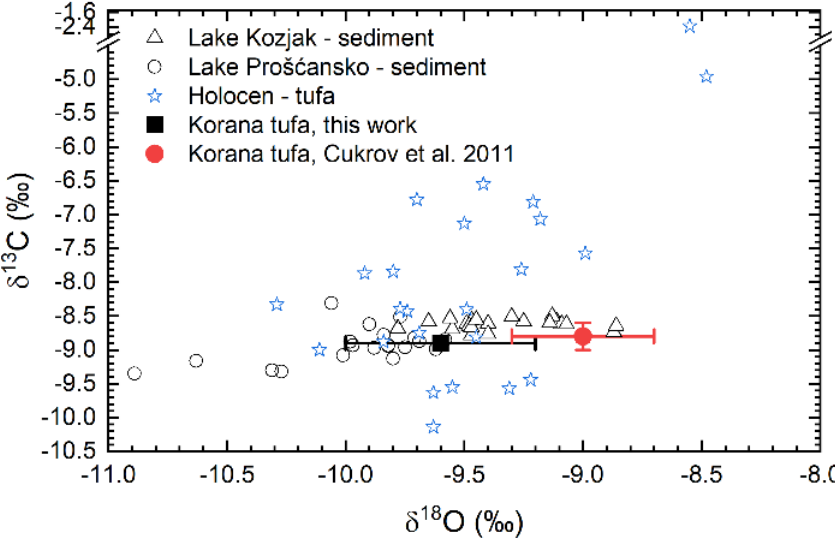
Figure 5. δ 13 C vs. δ 18 O for the Plitvice Lakes sediments from Lake Kozjak and Lake Proš´cansko, for the Holocene tufa [36] and for tufa from the Korana River (data from this work and from Cukrov et al. [68]).